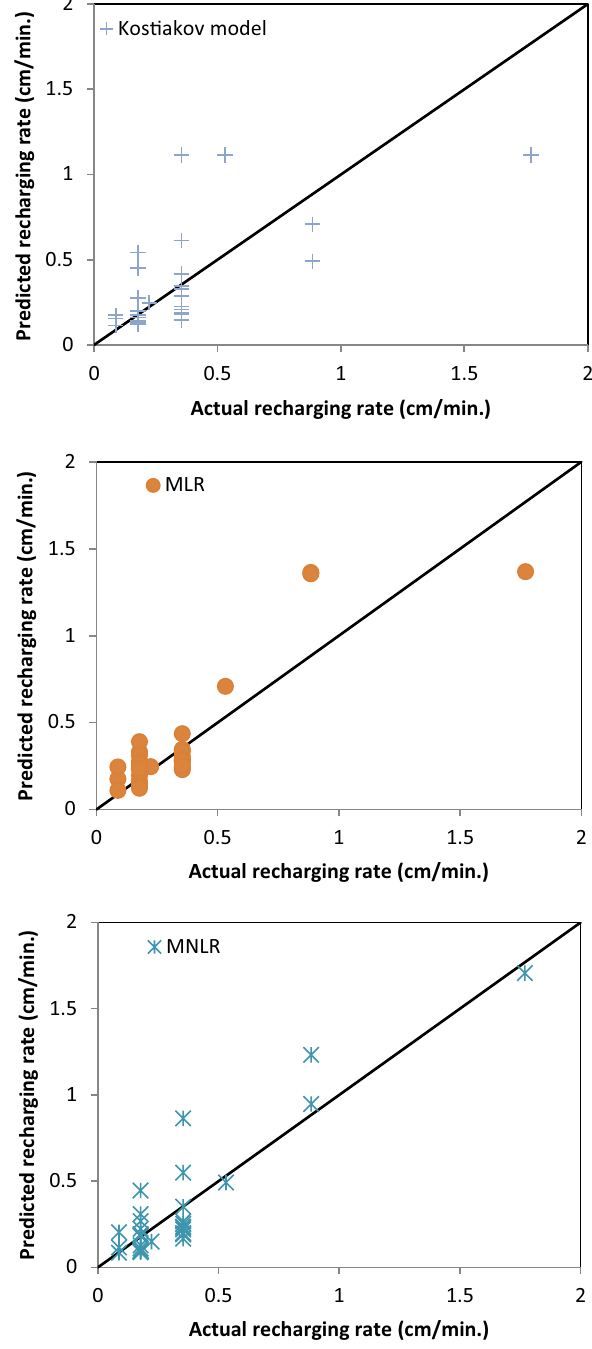
Fig. 2 Performance of empirical